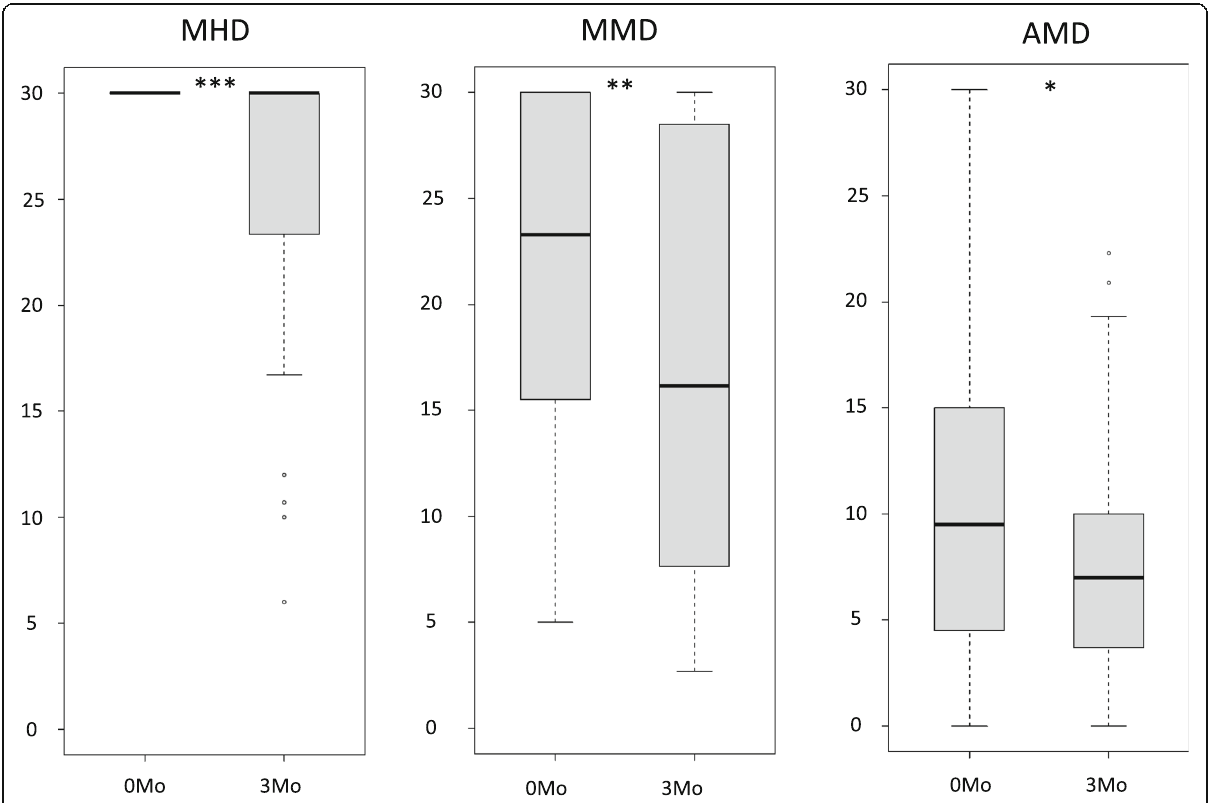
Fig. 1 Treatment response. Boxplot of monthly headache days (MHD), monthly migraine days (MMD) and monthly acute medication intake (AMD) (y-axis) before treatment (0 Mo) and after 3 months (3Mo) of treatment (x-axis). Median, first and third qantile as well as minimum and maximum are shown. MHD and MMD were significant reduced, AMD alterations were not significant (*** p = 0.009; ** p = 0.033; * p =